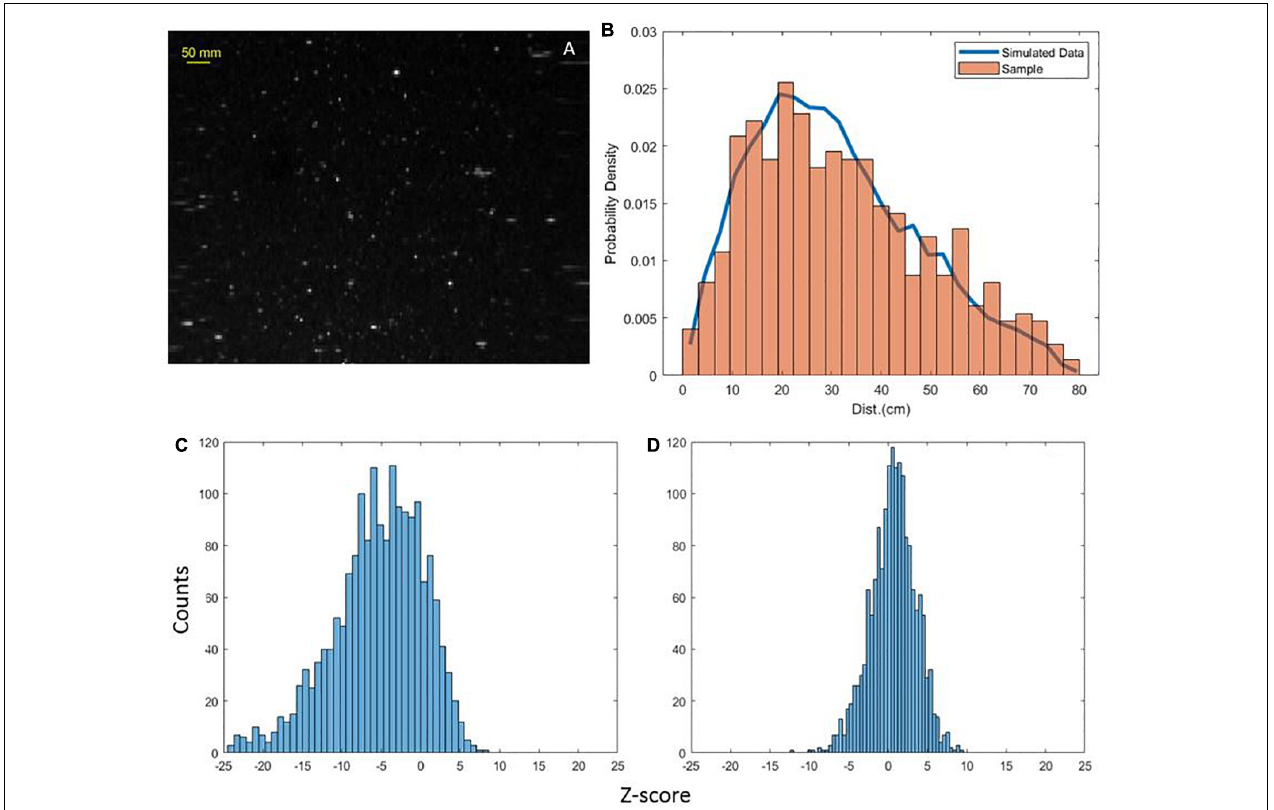
FIGURE 8 | Sample dense image from dawn station (A) . Probability density function of spatial distance of particles from sample image compared with simulated data (B) . Histogram of all calculated z -scores for dense scans at dusk (C) and dawn (D)